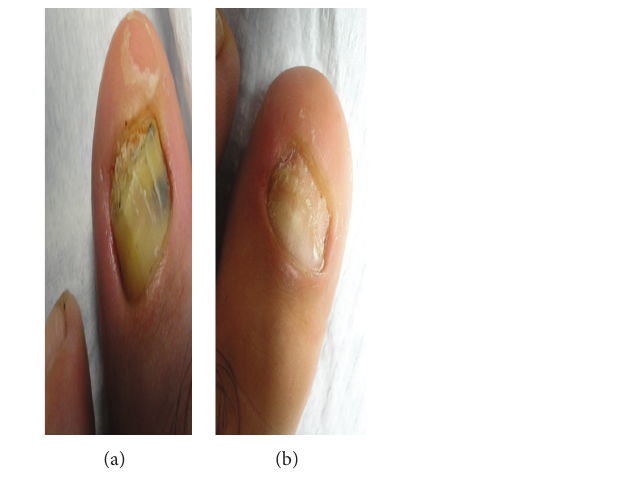
Figure 6: (a) 32-year-old male patient, before treatment. Trichophyton rubrum was isolated on mycological testing. OSI was 35. (b) After treatment with great improvement. OSI is 12 showing 65.71% improvement.